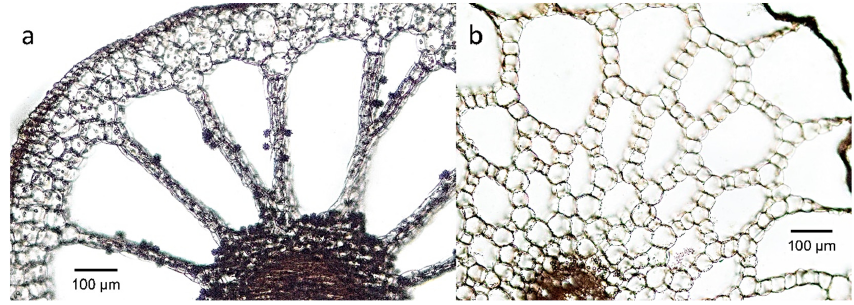
Figure 1. Transection of stems of two submerged species showing different types of aerenchyma; ( a ) lysigenous in Myriophyllum spicatum and ( b ) schizogenous in Potamogeton crispus. Photo: Matej Holcar.